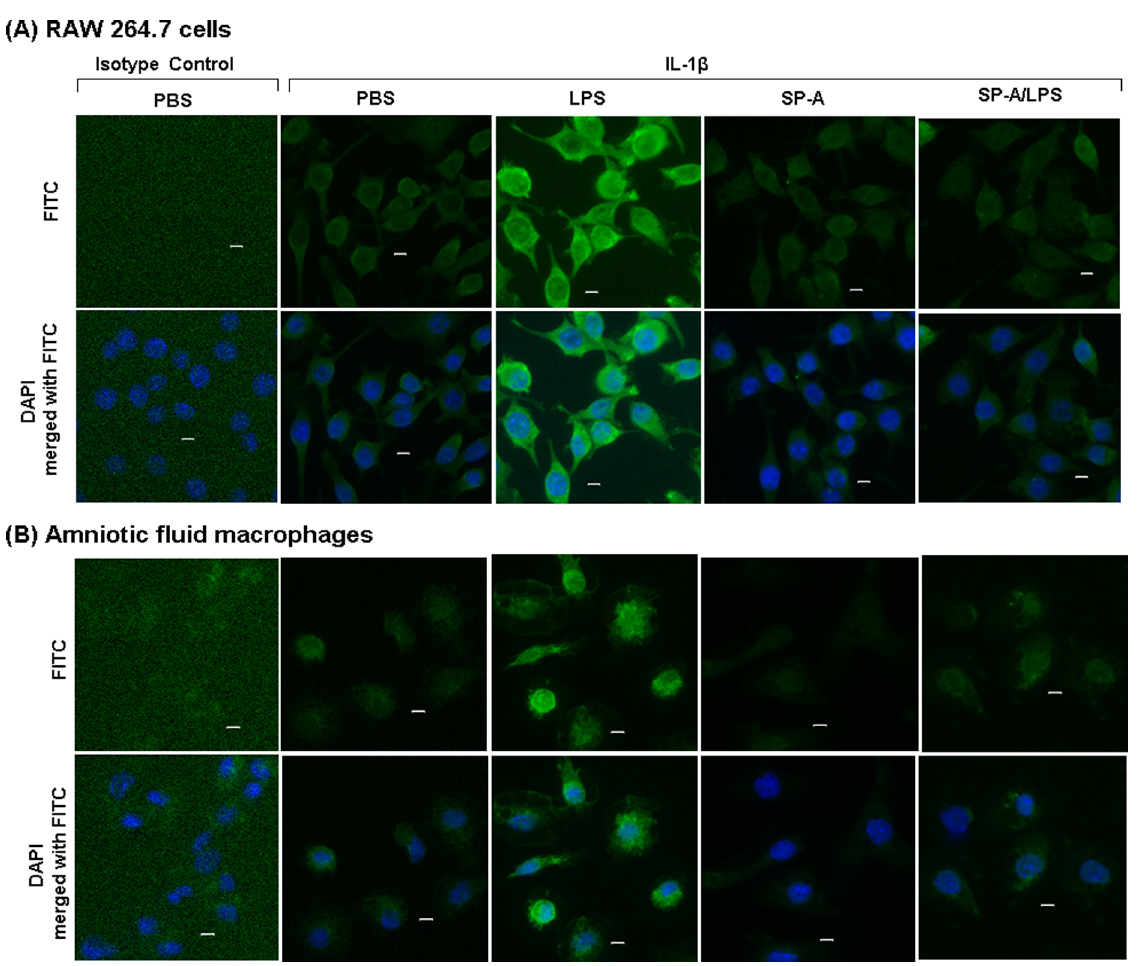
Figure 5. SP-A suppresses TLR ligand-induced expression of IL-1 b in a macrophage cell line and in amniotic fluid macrophages. Immunocytochemistry with anti-IL-1 b or an isotype-control antibody, each labeled with the fluorescent dye FITC, one hour after treatment with PBS or LPS with or without SP-A in RAW264.7 cells (A) and Day 16.5 amniotic fluid macrophages (B). n=3 replicates per condition per experiment. Depicted is a representative figure from three repeat experiments. Top row: fluorescent microscopy for FITC (green). Bottom row: DAPI nuclear stain